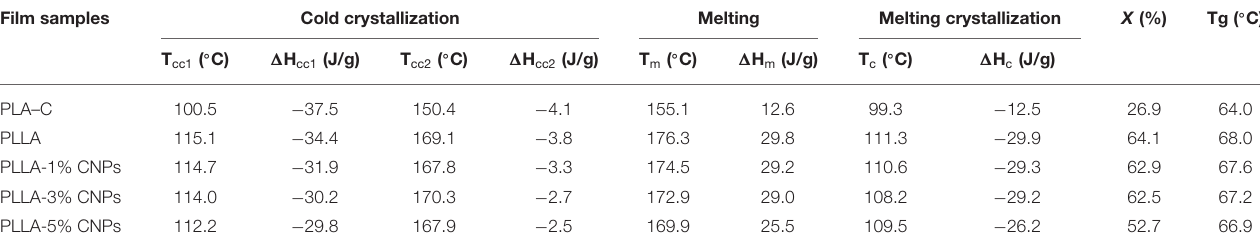
TABLE 4 | Thermal properties of poly (L-lactic acid) (PLLA) nanocomposite films, compared to neat PLA and PLLA films. Film